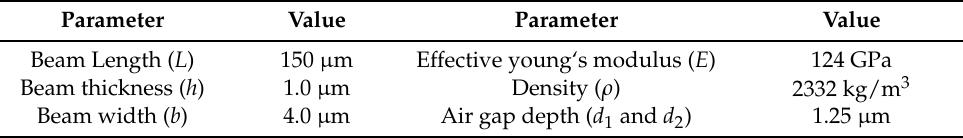
Table 1. Selected case study of a double-microbeams based actuator.